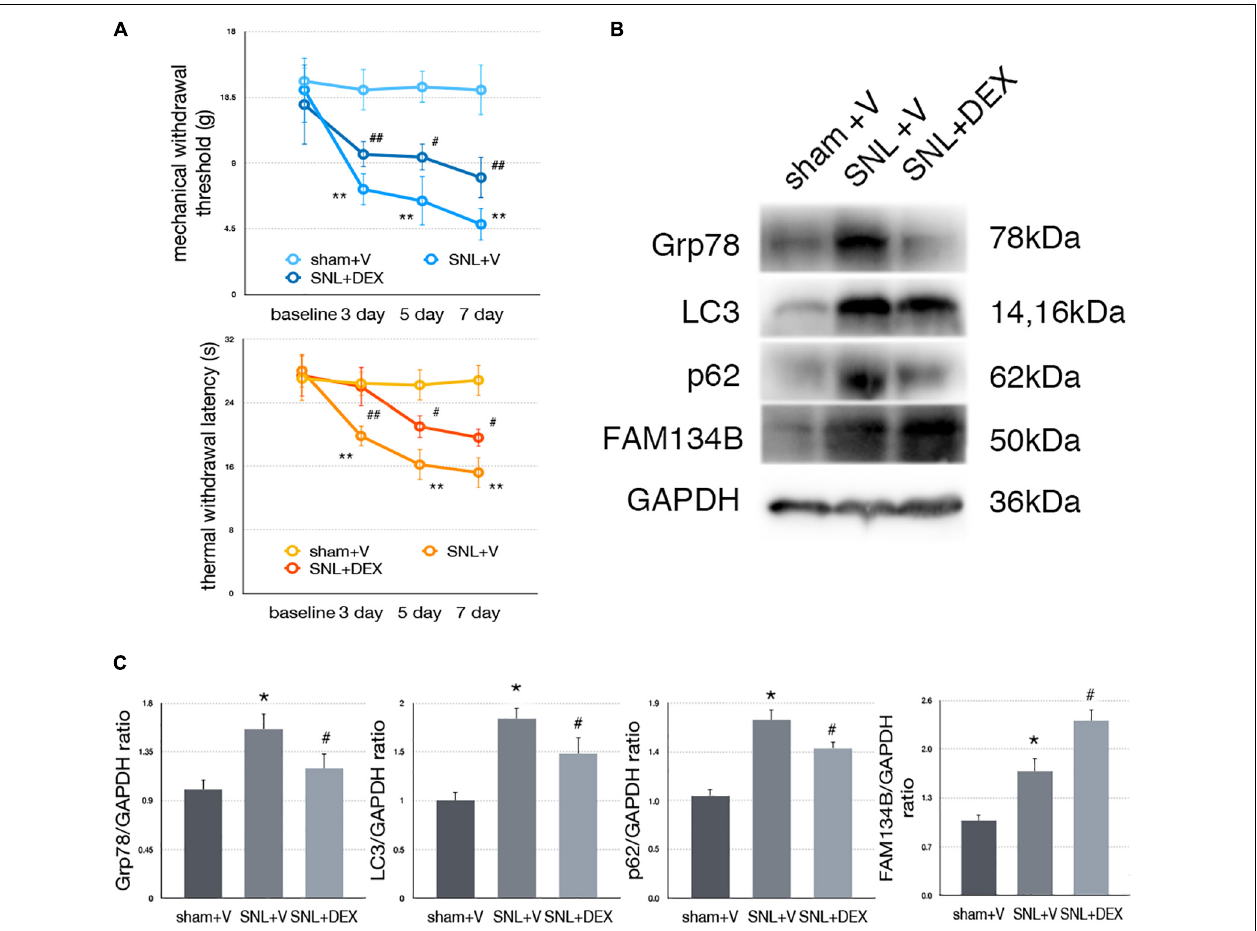
FIGURE 7 | Dexmedetomidine enhanced ER-phagy and alleviated ER stress to provide analgesic effect. (A) Dexmedetomidine improved MWT and TWL tests. (B) Protein expressions of Grp78, LC3, p62, and FAM134B in sham + V, SNL + V, and SNL + DEX group. (C) Quantifications of Western blot in sham + V, SNL + V, and SNL + DEX group. Data are presented as mean ± SD, n = 6 rats per group. * p < 0.05 SNL + V group vs. sham + V group; # p < 0.05 SNL + V vs. SNL + DEX group. In behavior tests, ** p < 0.01, ## p <